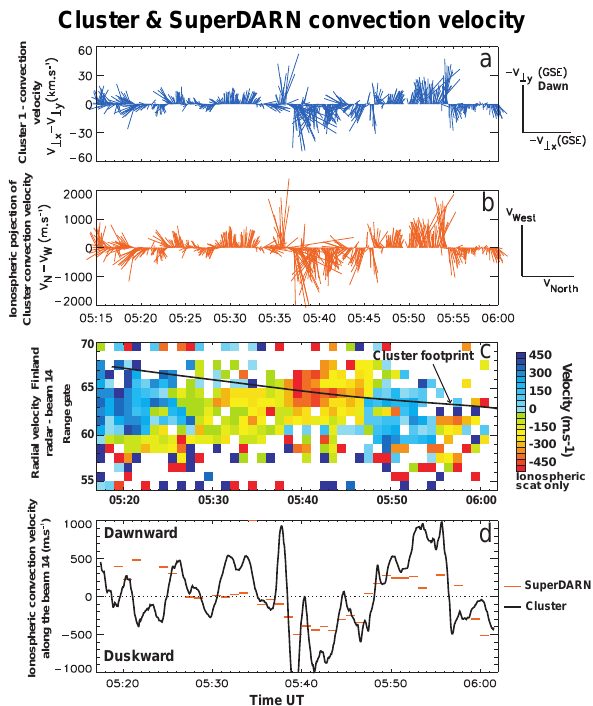
Fig. 4. Convection velocity measured by SuperDARN and Cluster. (a) Cluster 1 CIS ion perpendicular velocity vectors. Each vector represents the perpendicular-to-B component of the plasma veloc- ity projected onto the XY GSE plane. Because the local magnetic field is close to the ZGSE direction, the YGSE component is mainly dawnward. (b) Projection into the ionosphere at 250km altitude of the CIS velocity vectors, where V west and V north correspond to the velocity components in the magnetic west and north directions, re- spectively, in AACGM coordinates. (c) Range-time plot of LOS velocity for the SuperDARN Hankasalmi beam 14 with the Clus- ter footprint superimposed (black line). Positive (negative) Doppler velocities correspond to flow toward (away from) the radar. (d) Comparison of velocity measured by Cluster (solid black line) and SuperDARN (red segments). The Cluster CIS velocity has been av- eraged over 1min and projected along the beam 14 of Hankasalmi. The SuperDARN velocity is the radial velocity measured at the Cluster footprint. (From Marchaudon et al.,